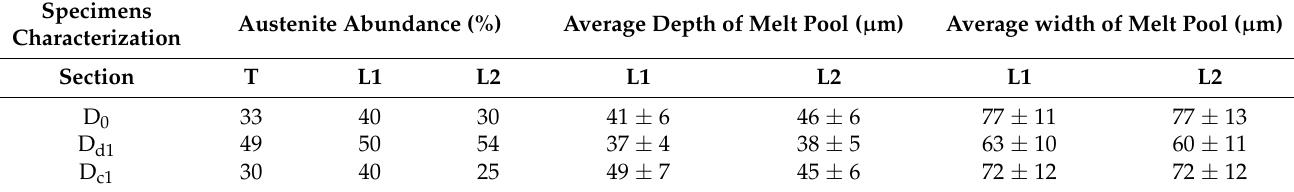
Table 3. Amount of austenitic phase evaluated as ratio between austenitic phase area and total area (%), average depth and width of the melt pool ( µ m).